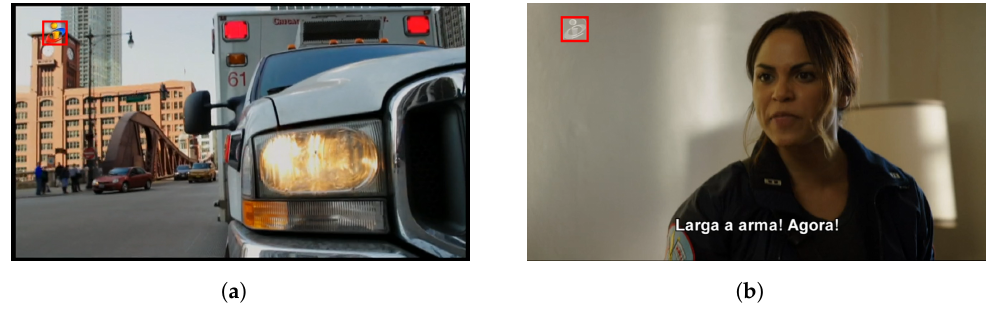
Figure 4. Comparison between the general TVI channel logo and the logo used to advertise an upcoming program. ( a ) Program scene where the typical colored version of the channel logo is visible in the top left corner. ( b ) Grayscale version of the logo on an advertisement of an upcoming program. Given the differences between streams and even within the same stream, we